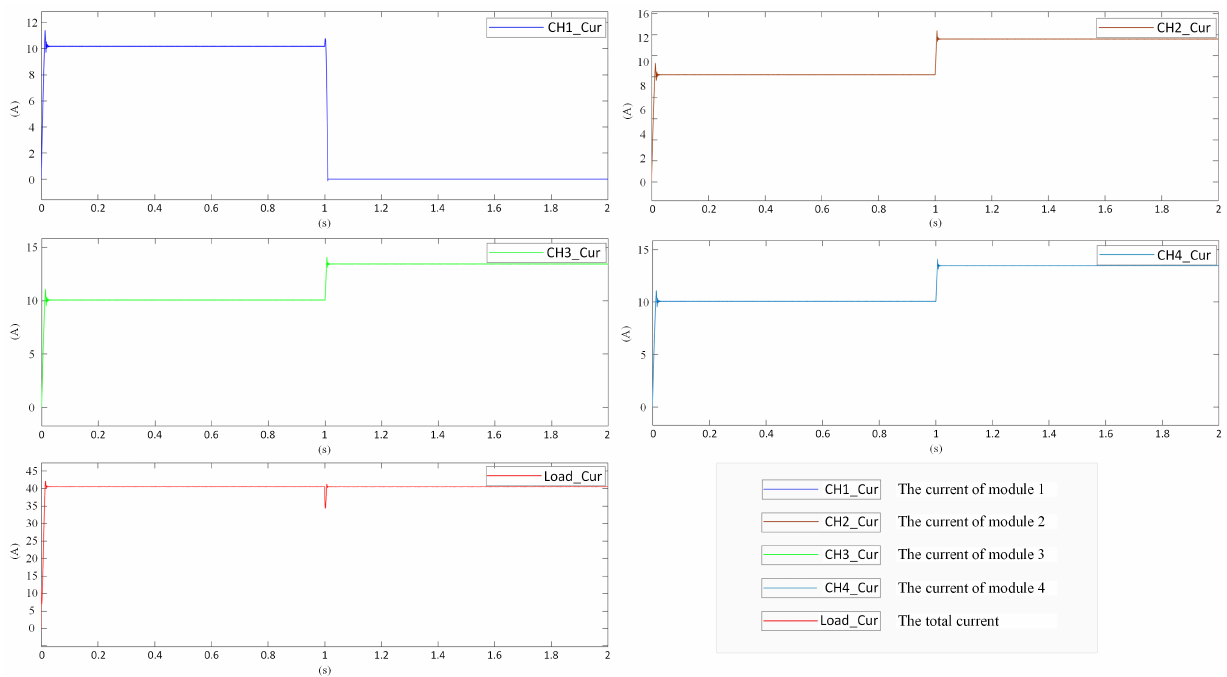
Figure 8. Simulation result of the 3 + 1 parallel redundant current